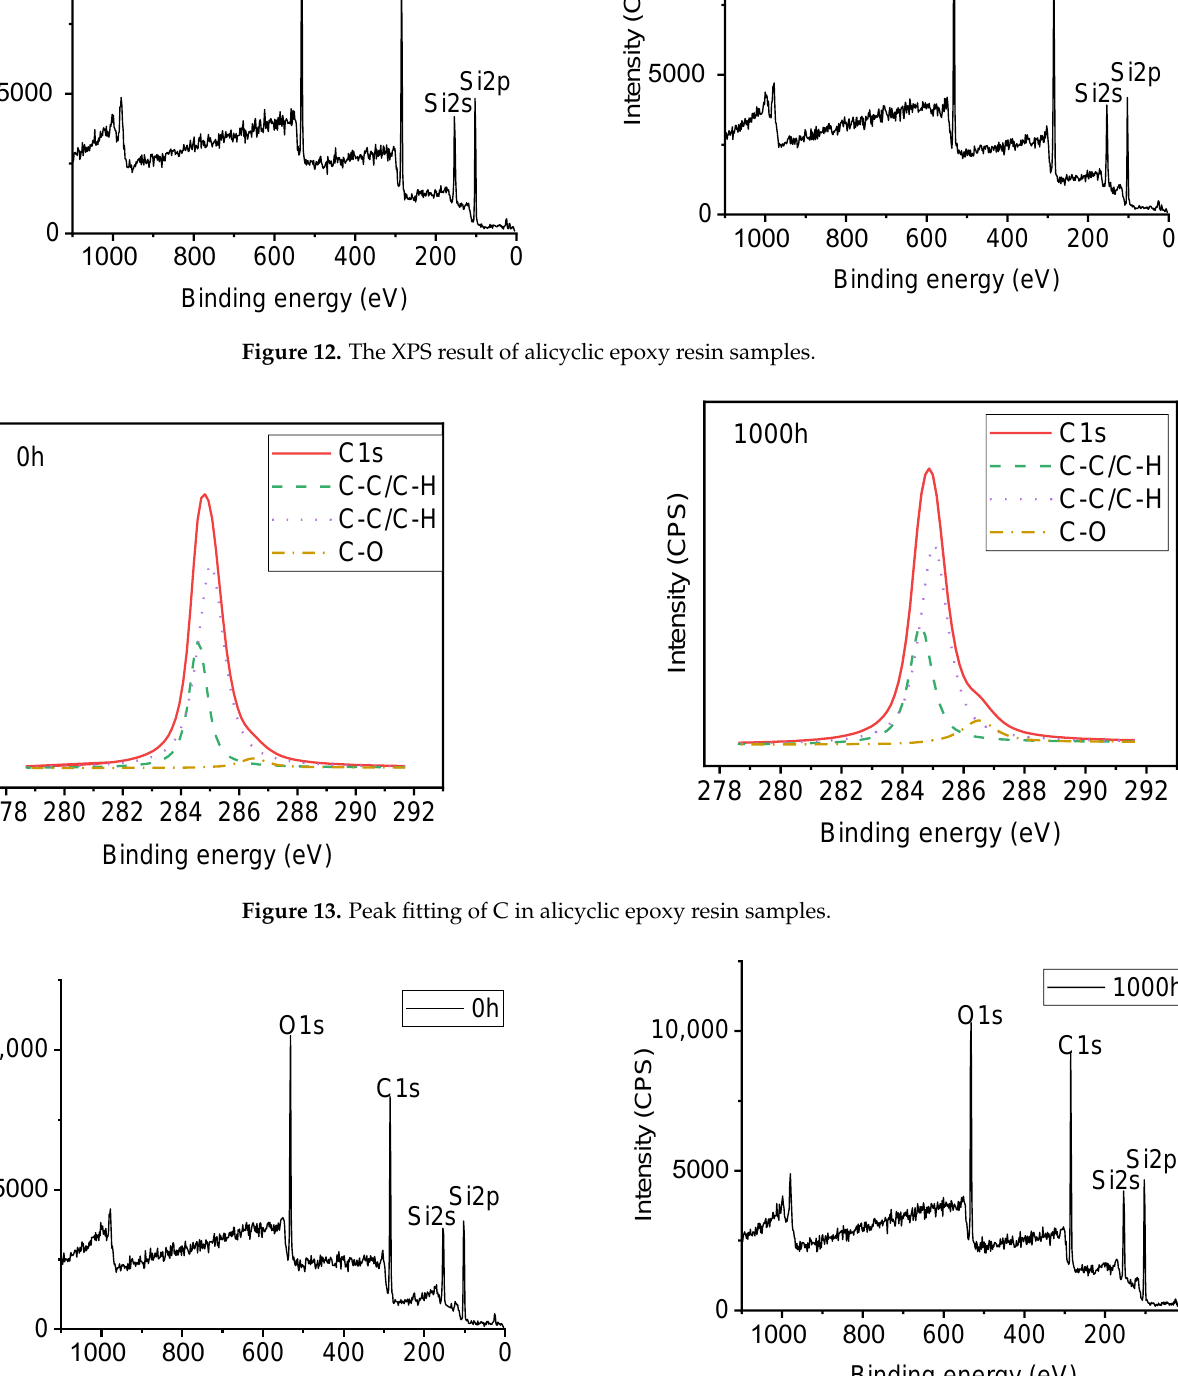
Figure 14. The XPS result of HTV silicone rubber samples.